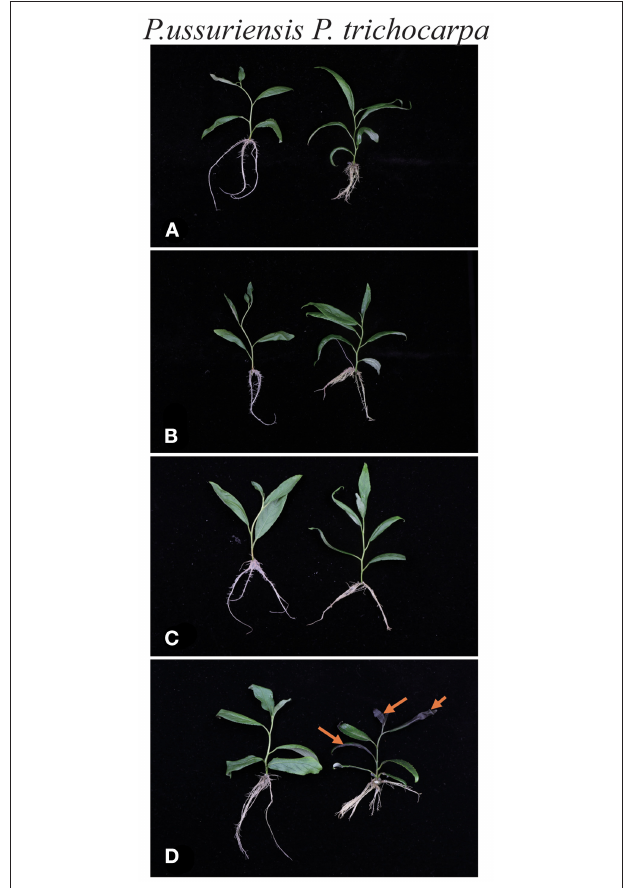
FIGURE 1 | Phenotypic changes in P. trichocarpa and P. ussuriensis in response to cold stress. P. trichocarpa and P. ussuriensis grown at 25 ◦ C for 3h (A) ; 3 ◦ C for 3h (B) ; − 3 ◦ C for 3h (C) ; and − 3 ◦ C for 4 h (D)